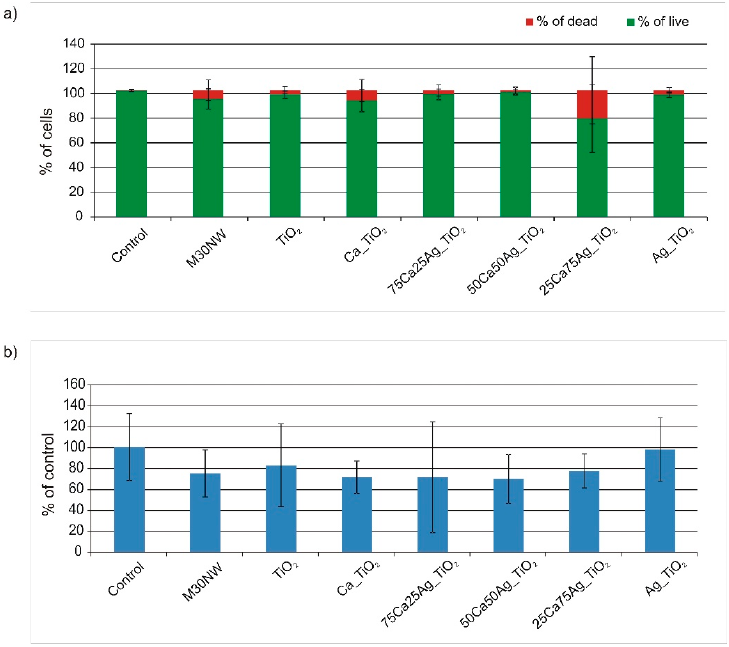
Figure 9. The results of ( a ) the live/dead test and ( b ) the cells’ proliferation evaluation for all the examined coatings after 48 h of direct contact (conducted according to the protocol of ISO 10993-5: Tests for Cytotoxicity—In Vitro Methods).